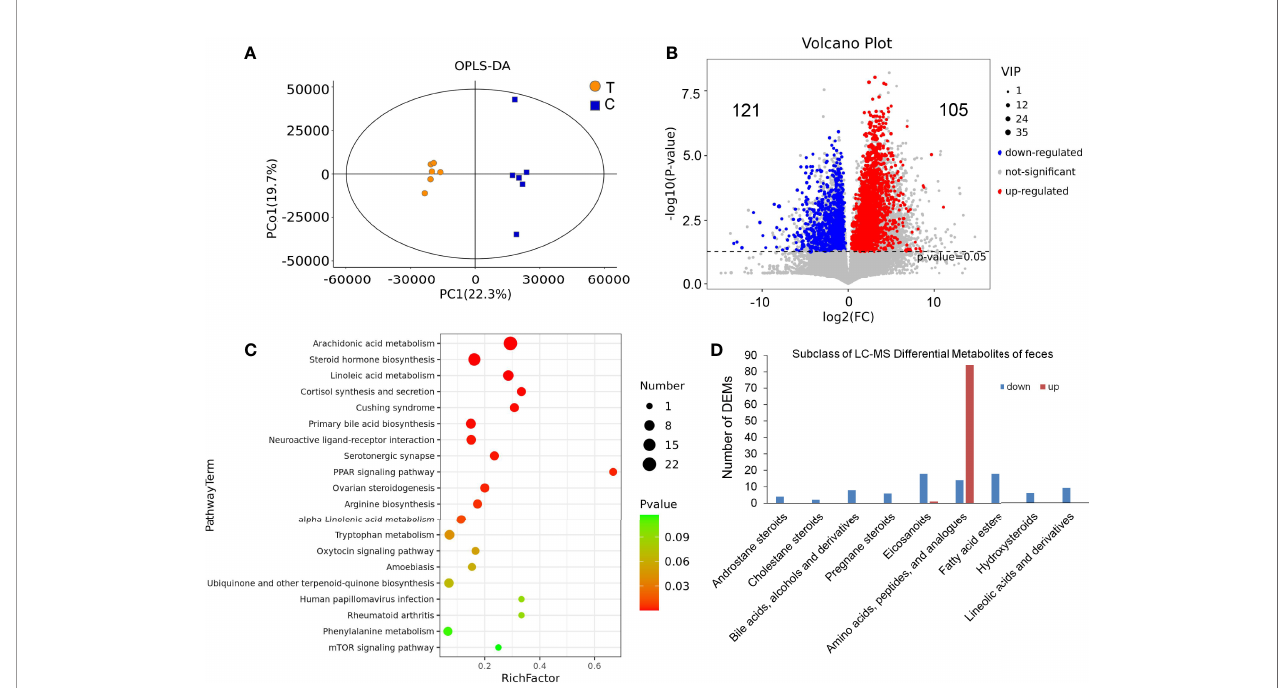
FIGURE 9 | Feces LC-MS metabolomics analysis. (A) There were signi fi cant differences in OPLS-DA score between the thyrotoxicosis group (T) and the normal group (C). (B) The Volcano plot of 226 DEMs (HMDB database), including 105 upregulated ones and 121 downregulated ones. (C) The KEGG pathway analysis result of all DEMs. (D) The classi fi cation of LC-MS DEMs.